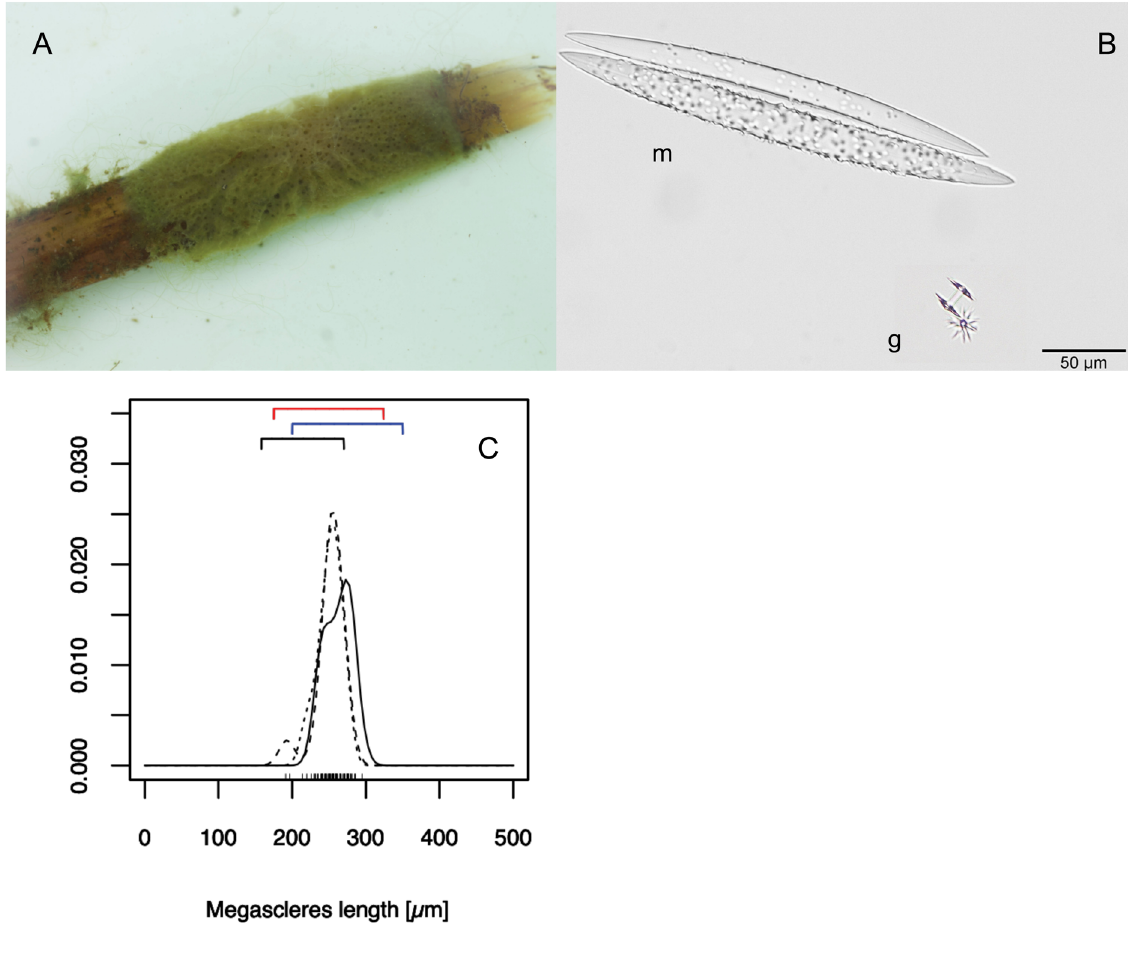
Fig. 4. Ephydatia muelleri (Lieberkühn, 1856) . A . Habitus (P059-170829-4). B . Spiculae, m = megascleres (P059-170830-13), g = gemmuloscleres (P059-130828-18). C . Estimated megasclere size distribution within and between specimens, P059-130829-3 (solid line), P059-170830-13 (dashed) and UP-16-1-2 (dotted). Marks on the x-axis represent spiculae measured. Brackets correspond to ranges in literature (red = Tendal 1967b; blue = Penney & Racek 1968; black = Evans & Montagnes